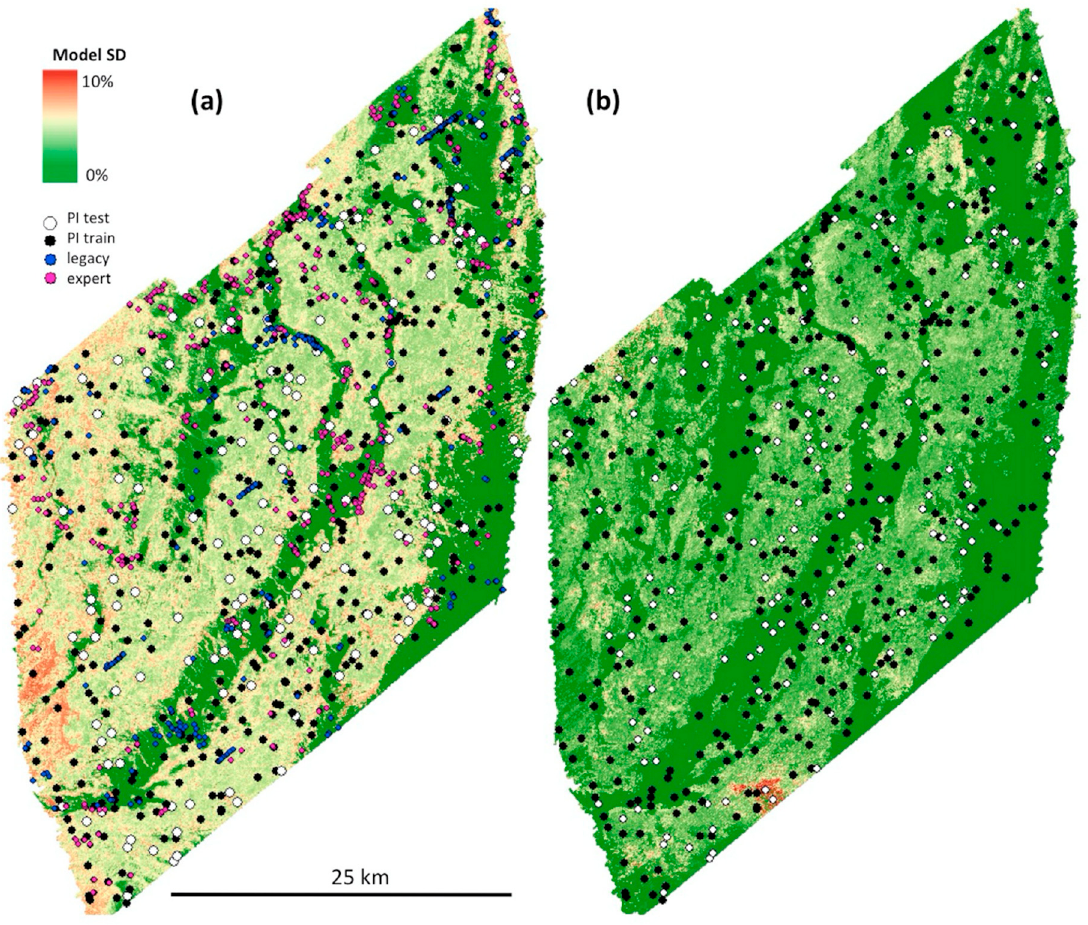
Figure 9. Locations of testing (PI stands for point intercept data from the 2016–2017 survey) and training data used for the modeling, as well as mean standard deviation for all continuous models tested for ( a ) substrate components (10 models of each component) and ( b ) biological components (5 models for each component). The maps are only intended to capture spatial patterns and cannot be used to compare the values between ( a ) and ( b ).